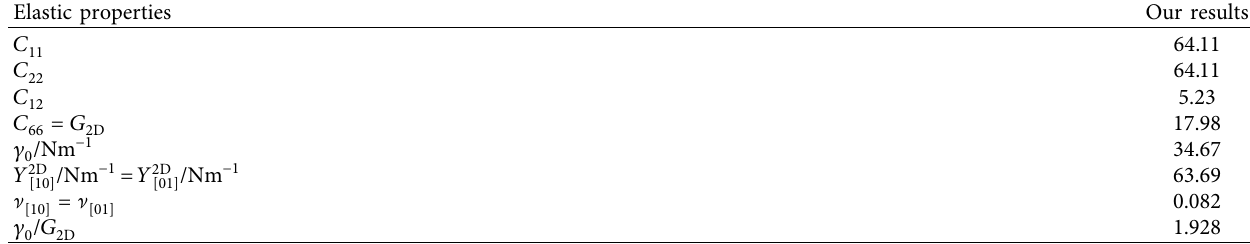
Table 1: Elastic constants C modulus, and sheer modulus ( c